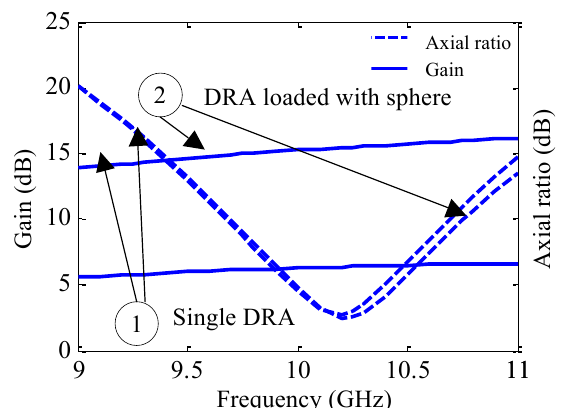
Figure 18: Geometry of the DRA loaded with